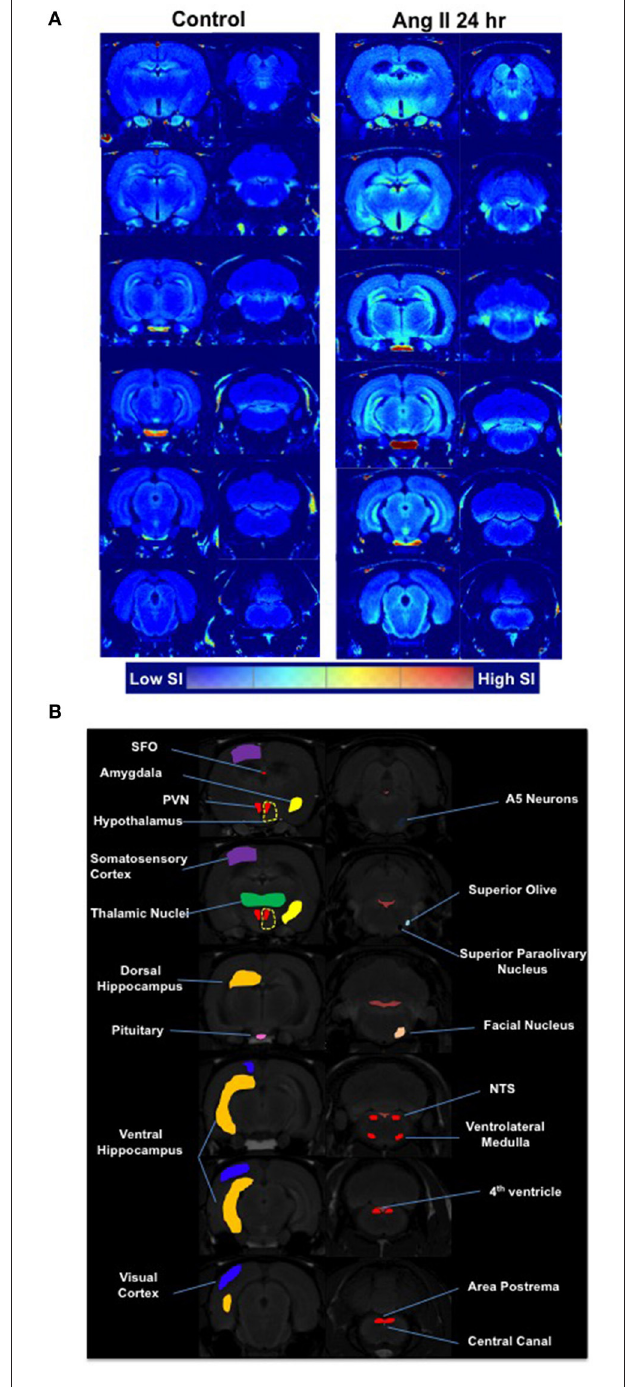
FIGURE 4 | Effects of systemic Ang II injection on the brain. (A) A single I.P. injection of Ang II caused a marked increase in the manganese-enhanced signal, corresponding to neuronal activation, in several nuclei of the forebrain and hindbrain as measured by MEMRI 24 h following Ang II injection (right panel) and compared to saline injection (left panel) (averaged from n = 6 per group). The brain segmentation slices are arranged consequentially from the brainstem regions (bottom left segment) through to the hypothalamic PVN region (bottom right segment). (B) Map of brain regions as per